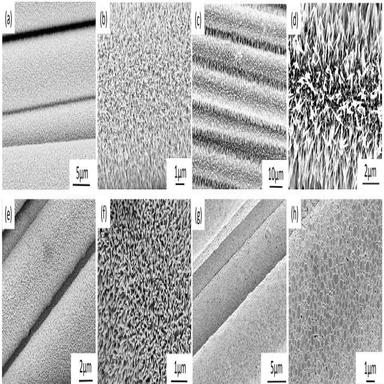
FESEM images of synthesized hybrid structural fibers: (a and b) FESEM images of ZnO fine nanowires on carbon fibers; (c and d) FESEM images of ZnO fuzzy nanowires on carbon fibers; (e and f) FESEM images of ZnO fine nanorods on carbon fibers; (g and h) FESEM images of compact nanorods on carbon fibers showing the fully coverage of carbon fiber by ZnO.